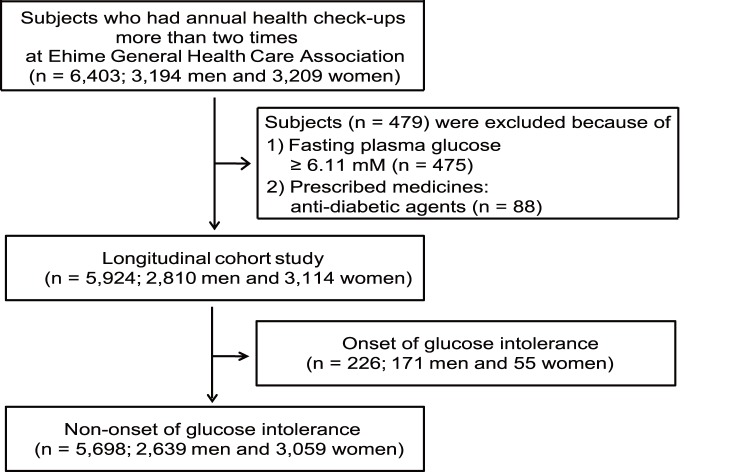
Recruitment flowchart for study participants.